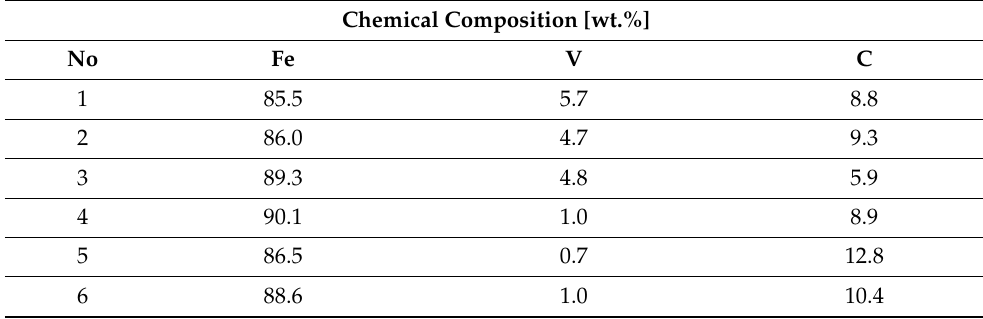
Table 2. Example of the chemical composition (point EDS) of the coating produced using 900 W.